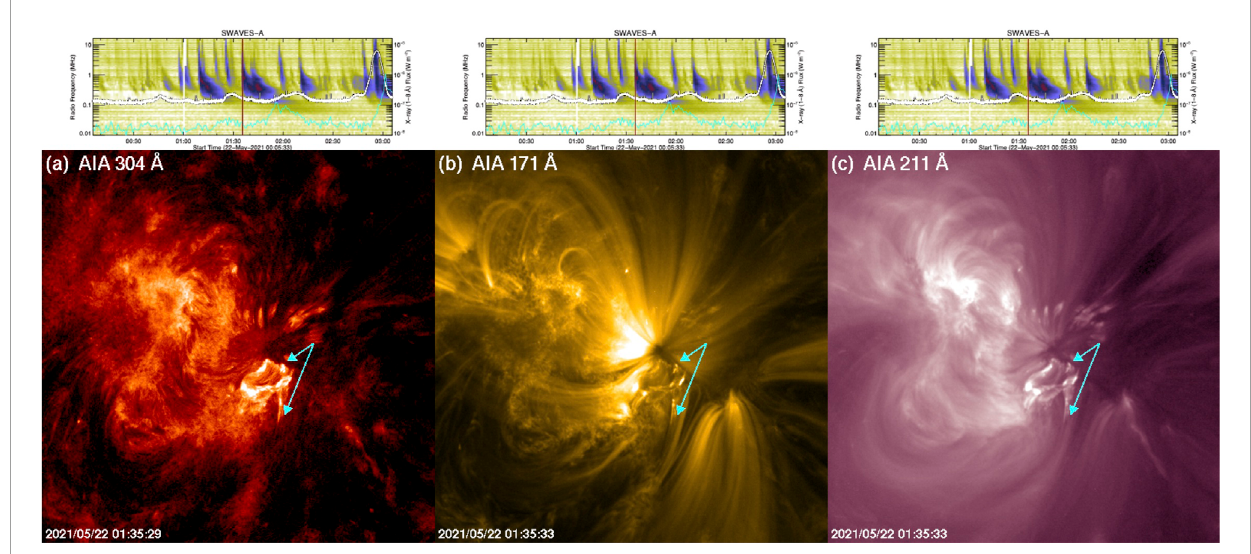
FIGURE 5 A jet captured in AIA images of AR 12824 in 304 Å, 171 Å, and 211 Å channels, respectively, in (A–C) . These are snapshots from movies (images and radio dynamic spectra) in the respective AIA channels. The arrows point to the footpoint and spire of the jet. The full-length movies are included as Supplementary Videos S1–S3 .